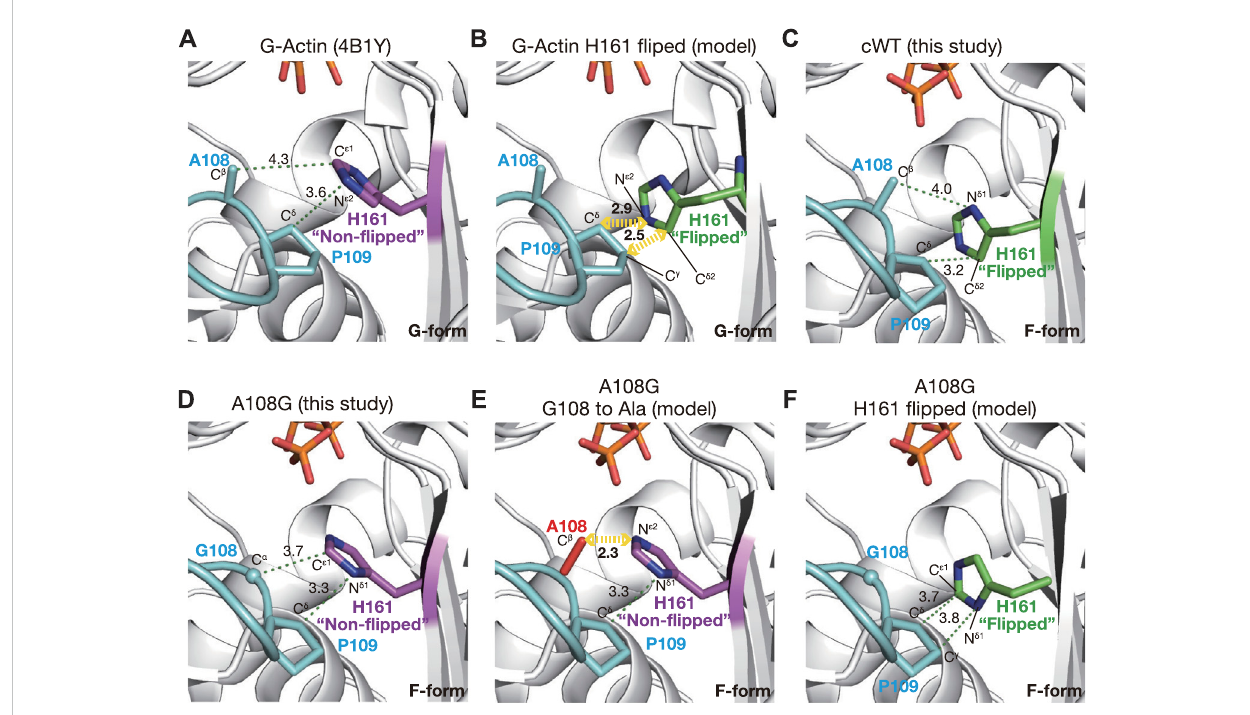
Mechanism of H161 fl ipping. The panels show the relationship between the Pro-rich loop and the rotameric conformations of His161 in crystal and modelstructures. (A) InaG-formactin(4B1Y),His161adoptsthenon- fl ippedconformation. (B) ModelstructureinwhichHis161of4B1Yisreplacedbythe fl ippingisunfavorableinG-actinduetoapredictedstericclashwithPro109. (C) IncWT_ADP- fl ippedHis161fromcWT_ADP-P i demonstratesthatHis161 P i ,His161inthe fl ipped conformation iscompatible with thePro-rich loop. (D) InA108G_ADP-P i ,due totheabsence ofthemethylgroup ofAla108, His161remainsnon- fl ippedevenintheF-formactin. (E) ModelstructurebasedonA108G_ADP-P i